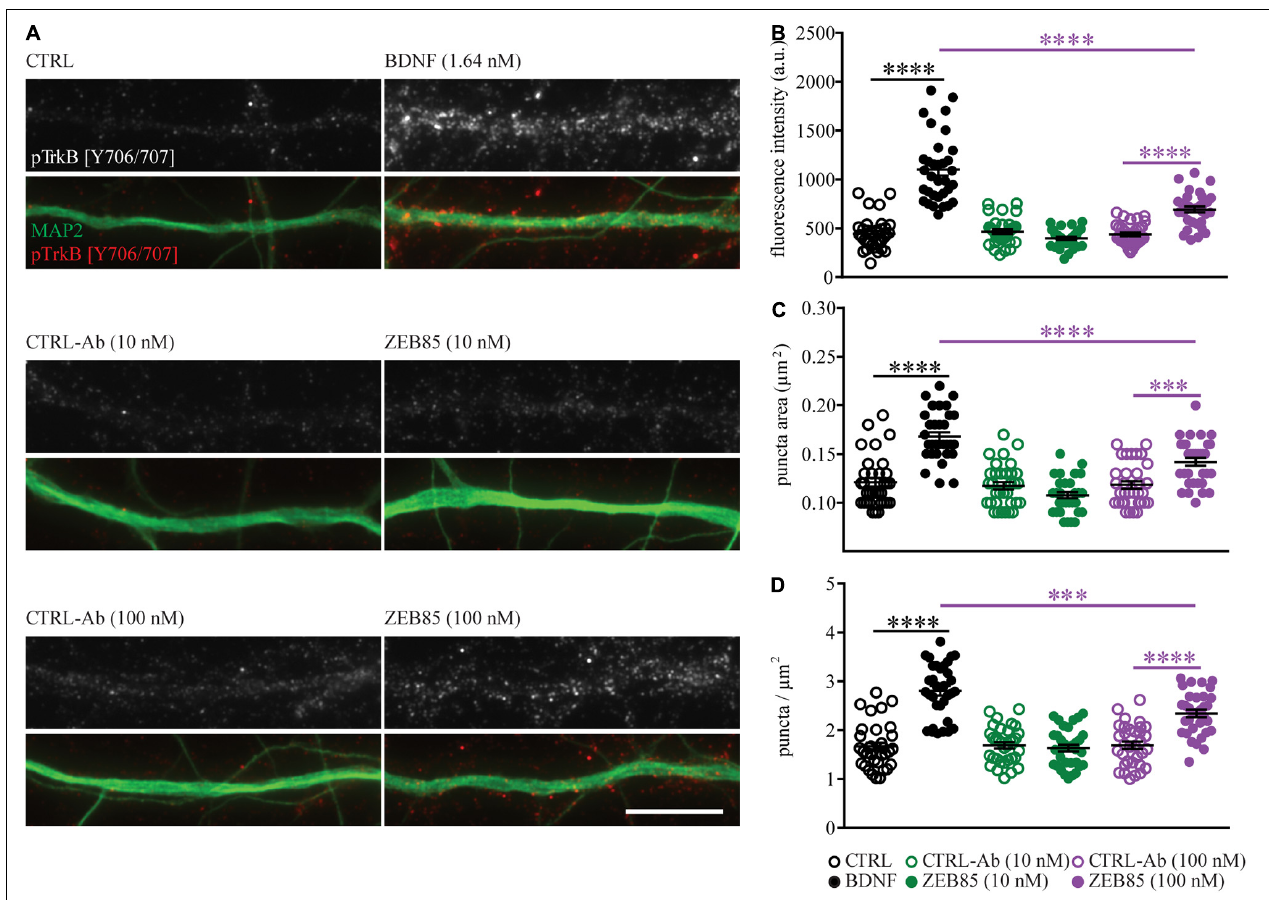
FIGURE 6 | ZEB85 leads to TrkB phosphorylation. Primary hippocampal cultures DIV21 were treated for 15 min with ZEB85 (10 nM and 100 nM), BDNF (1.64 nM) and the corresponding controls. (A) Representative dendritic segments immunostained for MAP2 and the TrkB phosphorylation site Tyr706/707 (pTrkB) shown for the different treatment groups. Scale bar, 10 µ m. (B) Quantification of pTrkB fluorescence intensity, (C) pTrkB puncta area, and (D) pTrkB density. ( n = 33 dendrites/neurons; N = 3 independent experiments). The data are presented as mean ± SEM and were tested using a one-way ANOVA with Bonferroni post-test. ∗∗∗ p < 0.001; ∗∗∗∗ p <